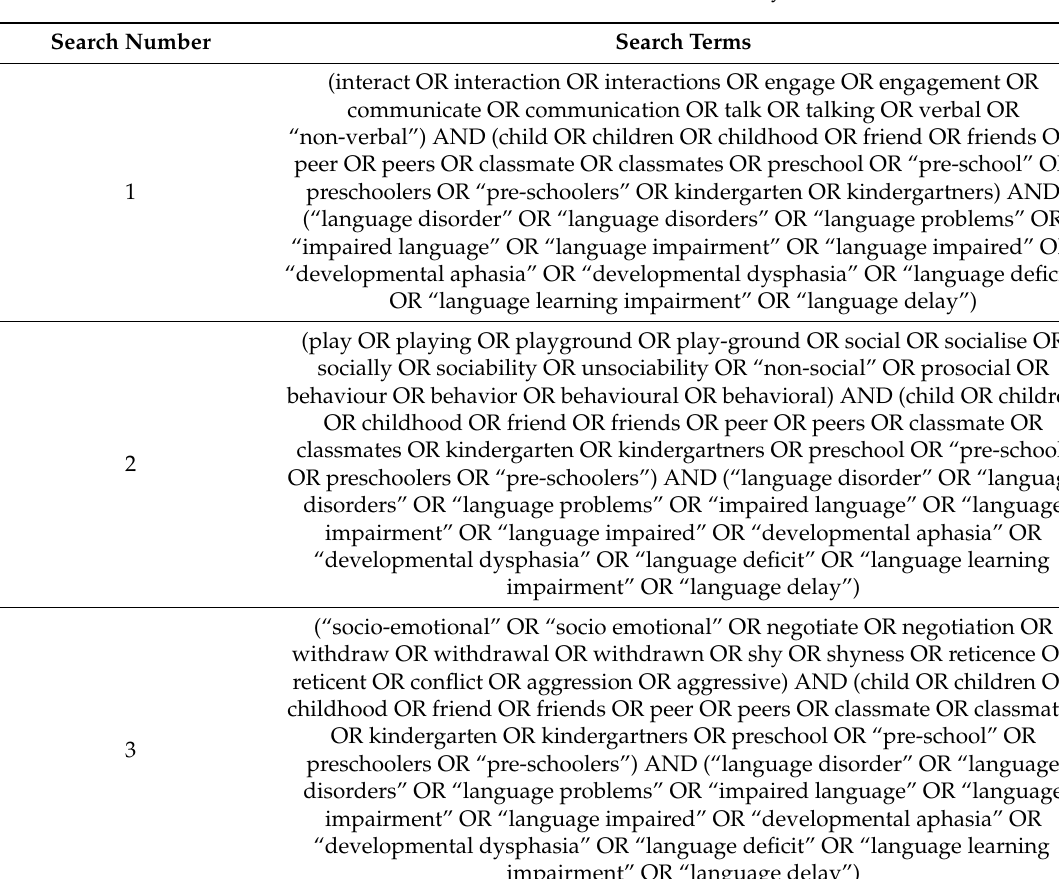
Table A1. Table to show the searches conducted in the current systematic